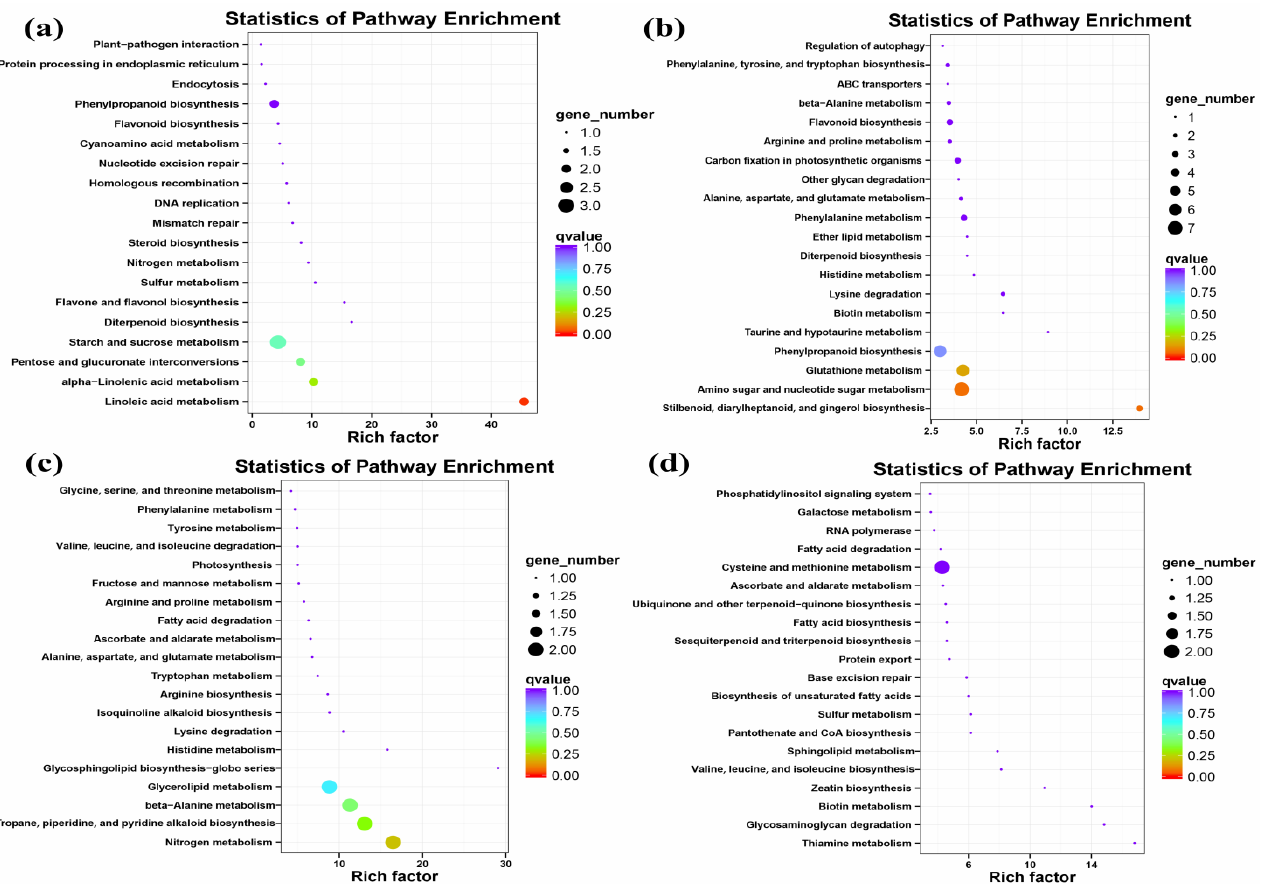
Figure 4. Pathways analysis of differentially expressed genes in leaf. ( a ) KEGG enrichment analysis of up-regulated genes at EL15; ( b ) down-regulated genes at EL15; ( c ) up-regulated genes at EL31; ( d ) down-regulated genes at EL31. The size of Bubbles represents the amount of genes, and the color represents the qvalue.